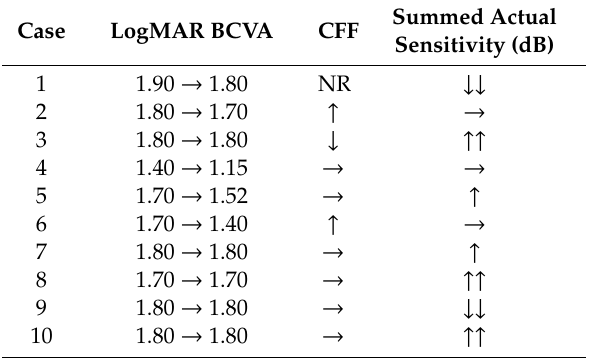
Table 3. The summary of the changes after SES in visual acuity, CFF, and visual field in each case. Summed Actual Case LogMAR BCVA CFF Sensitivity (dB)